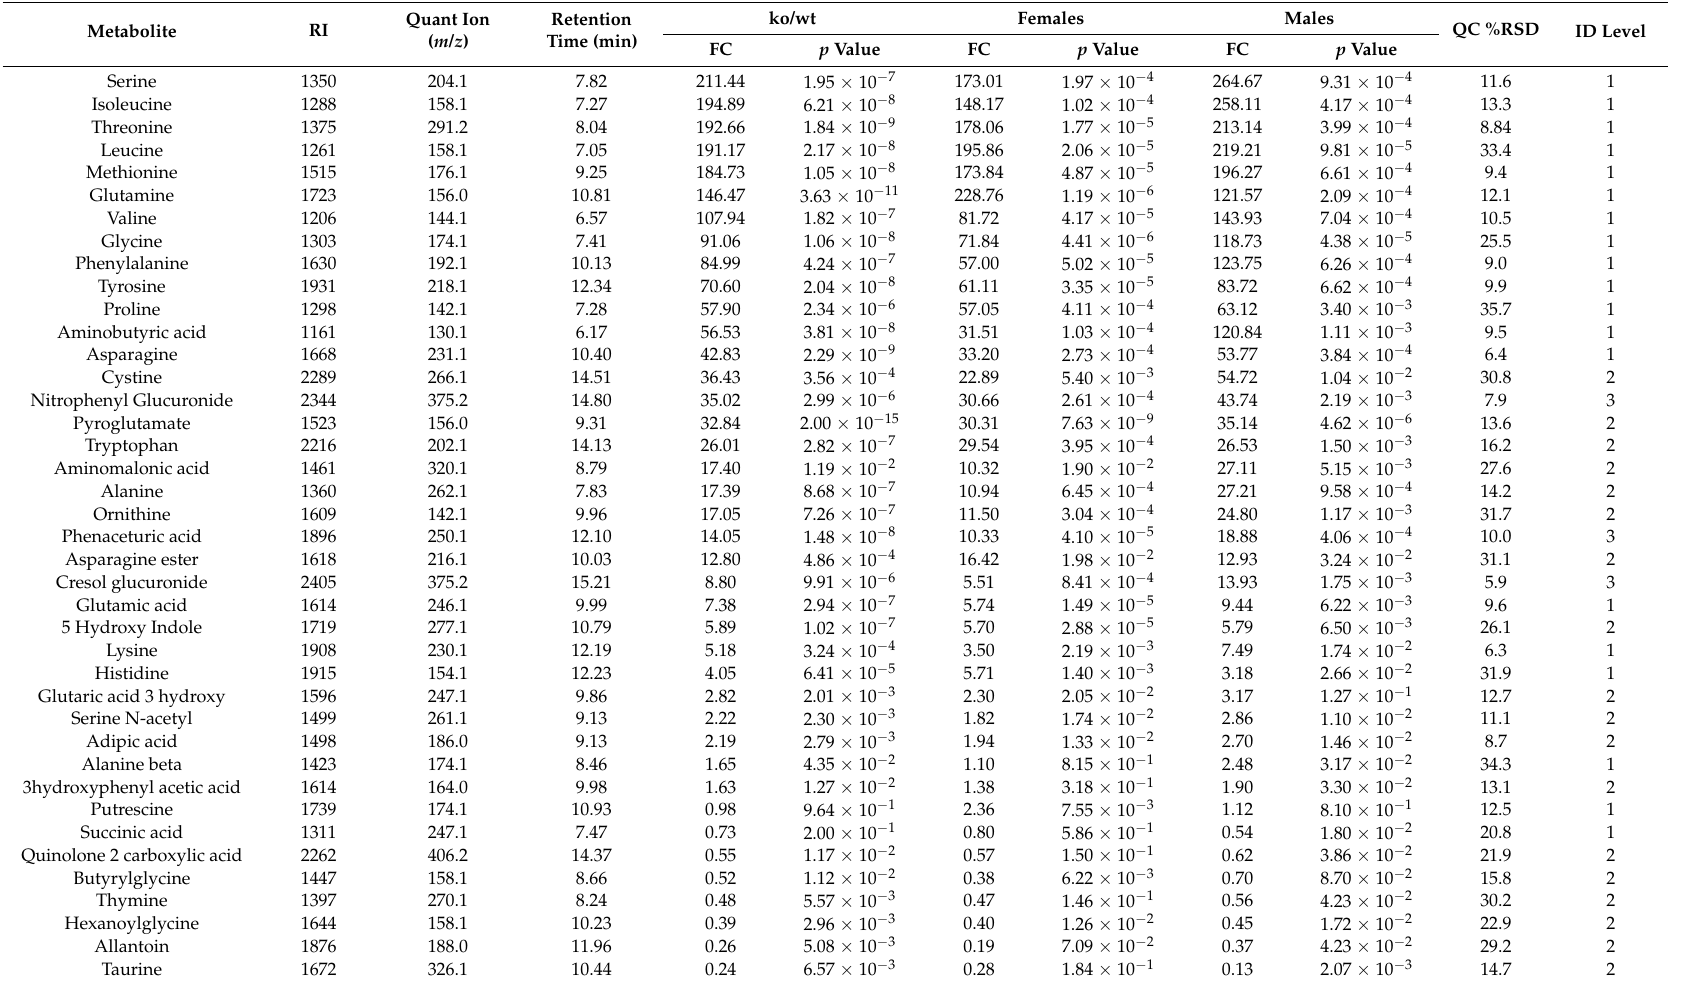
Table 2. Metabolites in the urine of SLC6A19ko and SLC6A19wt